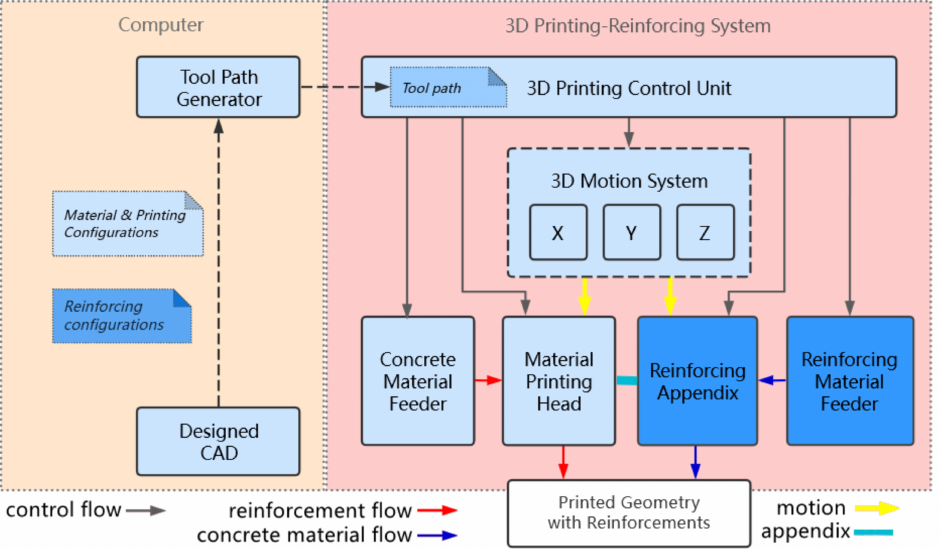
Figure 13. Schematic of the 3DCP and reinforcing system. The light-blue parts denote the existing 3DCP system, and the deep-blue parts are the reinforcing